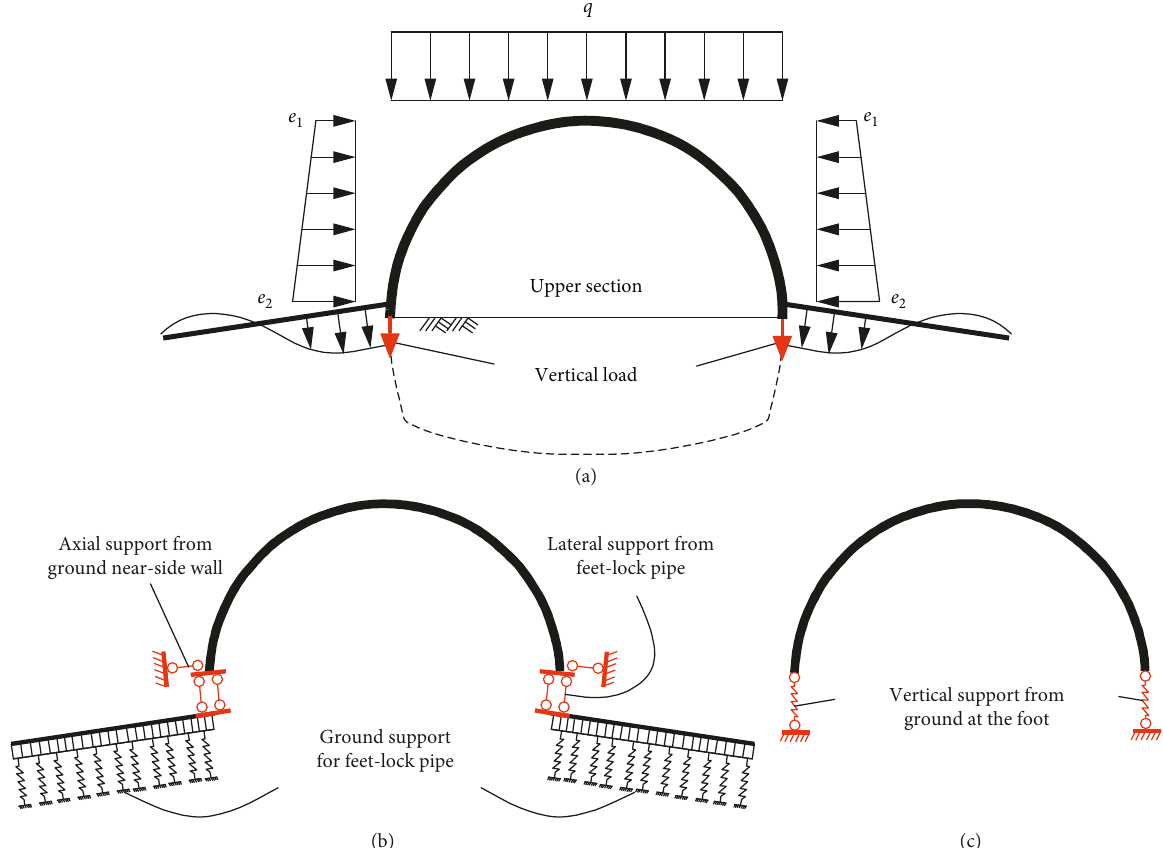
Figure 3: Ideal mechanical model of the steel rib, feet-lock pipe, and ground: (a) earth pressure acting on the steel rib; (b) ideal support between steel rib and feet-lock pipe; (c) ideal support between steel rib and upper-bench